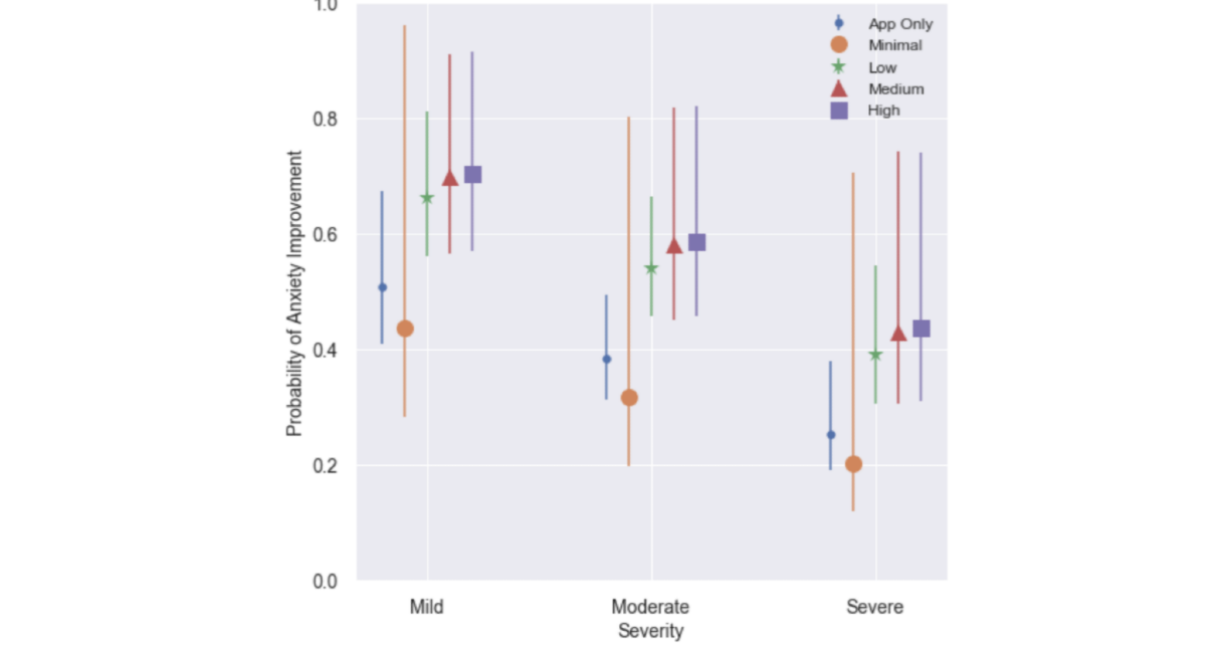
Figure 3. Probability of anxiety improvement by clinical utilization and intake severity among the clinical-only cohort (n=205). Shapes represent the expected mean probability of improvement by modality and intake severity; lines represent the corresponding 95% confidence interval.